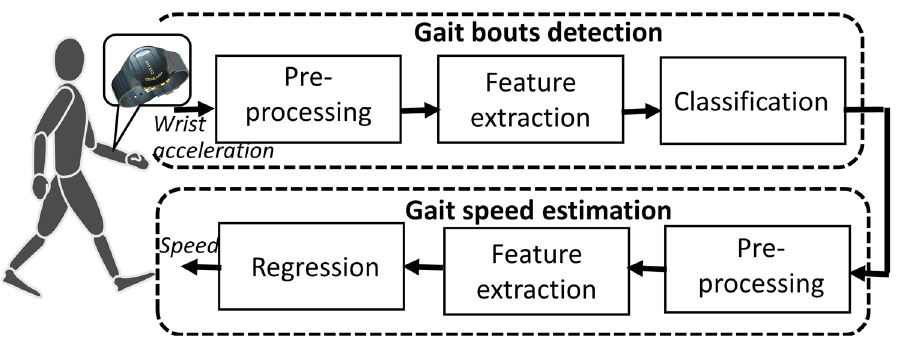
Figure 4. Block diagram of the system deployed for real-world gait speed estimation. Two validated algorithms were used, one for gait bout detection and the second for gait speed